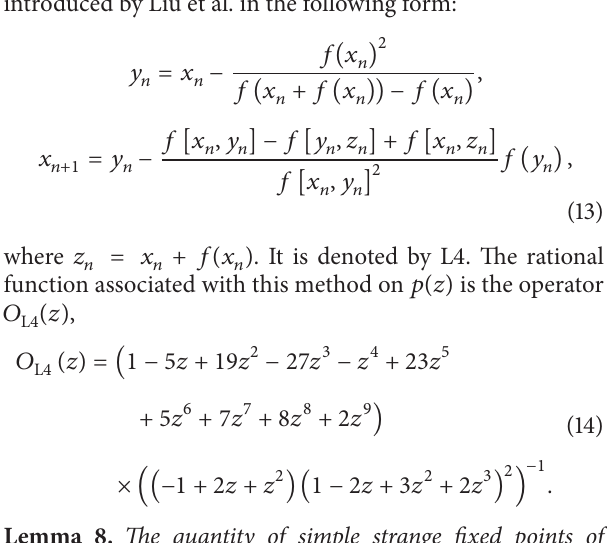
Figure 12: Real values of free critical points of 𝑂